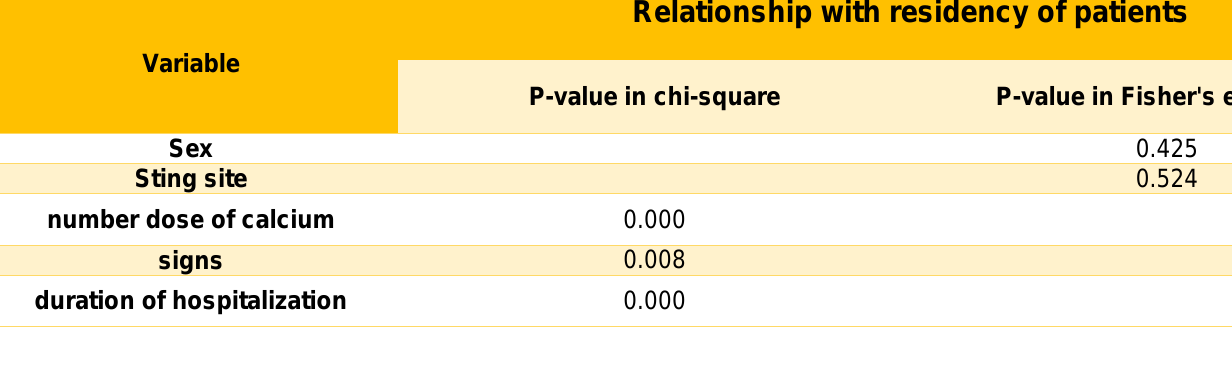
Statistical significance